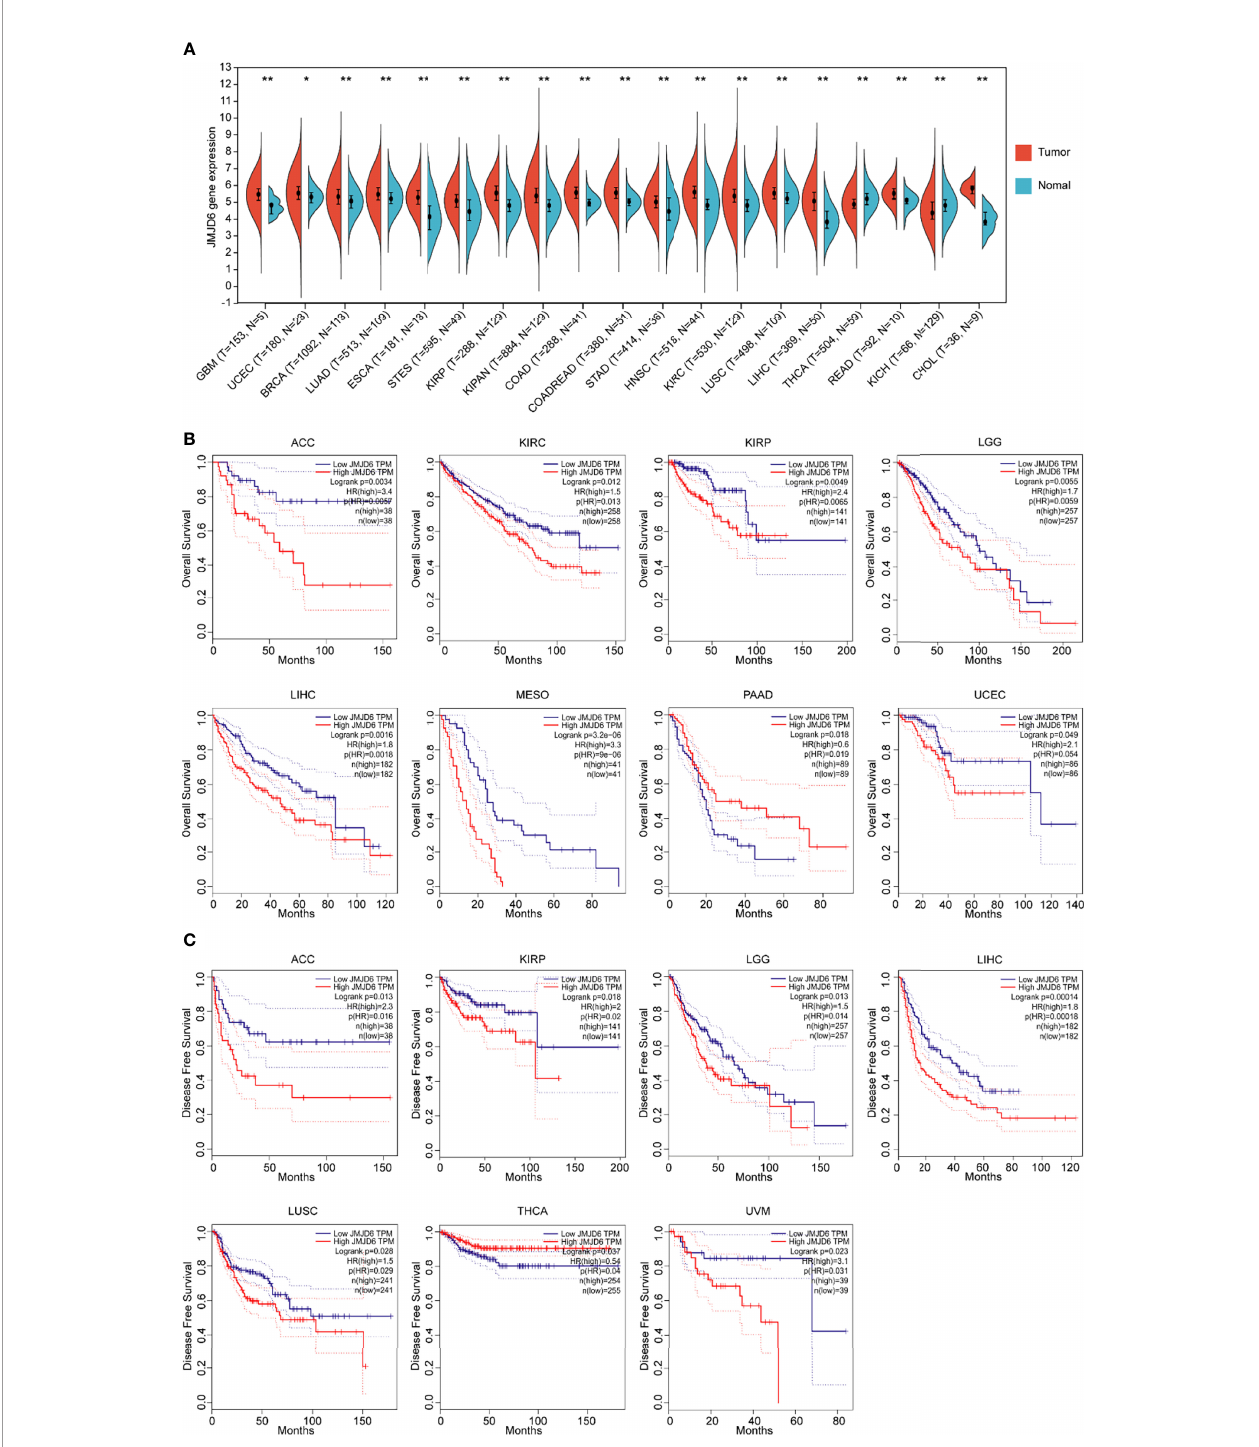
FIGURE 2 | Bioinformatics analysis of JMJD6 in tumors. (A) JMJD6 expression in distinct tumor samples (T) and paired normal samples (N) based on TCGA. Log2 (TPM + 1) transformation was performed for each expression value and tumor types with sample numbers less than three were eliminated for differential analysis. * p < 0.05, ** p < 0.01. (B) The correlation between JMJD6 expression level and OS; (C) The correlation between JMJD6 expression level and DFS. Correlation analysis was performed based on the GEPIA (http://gepia.cancer-pku.cn/)